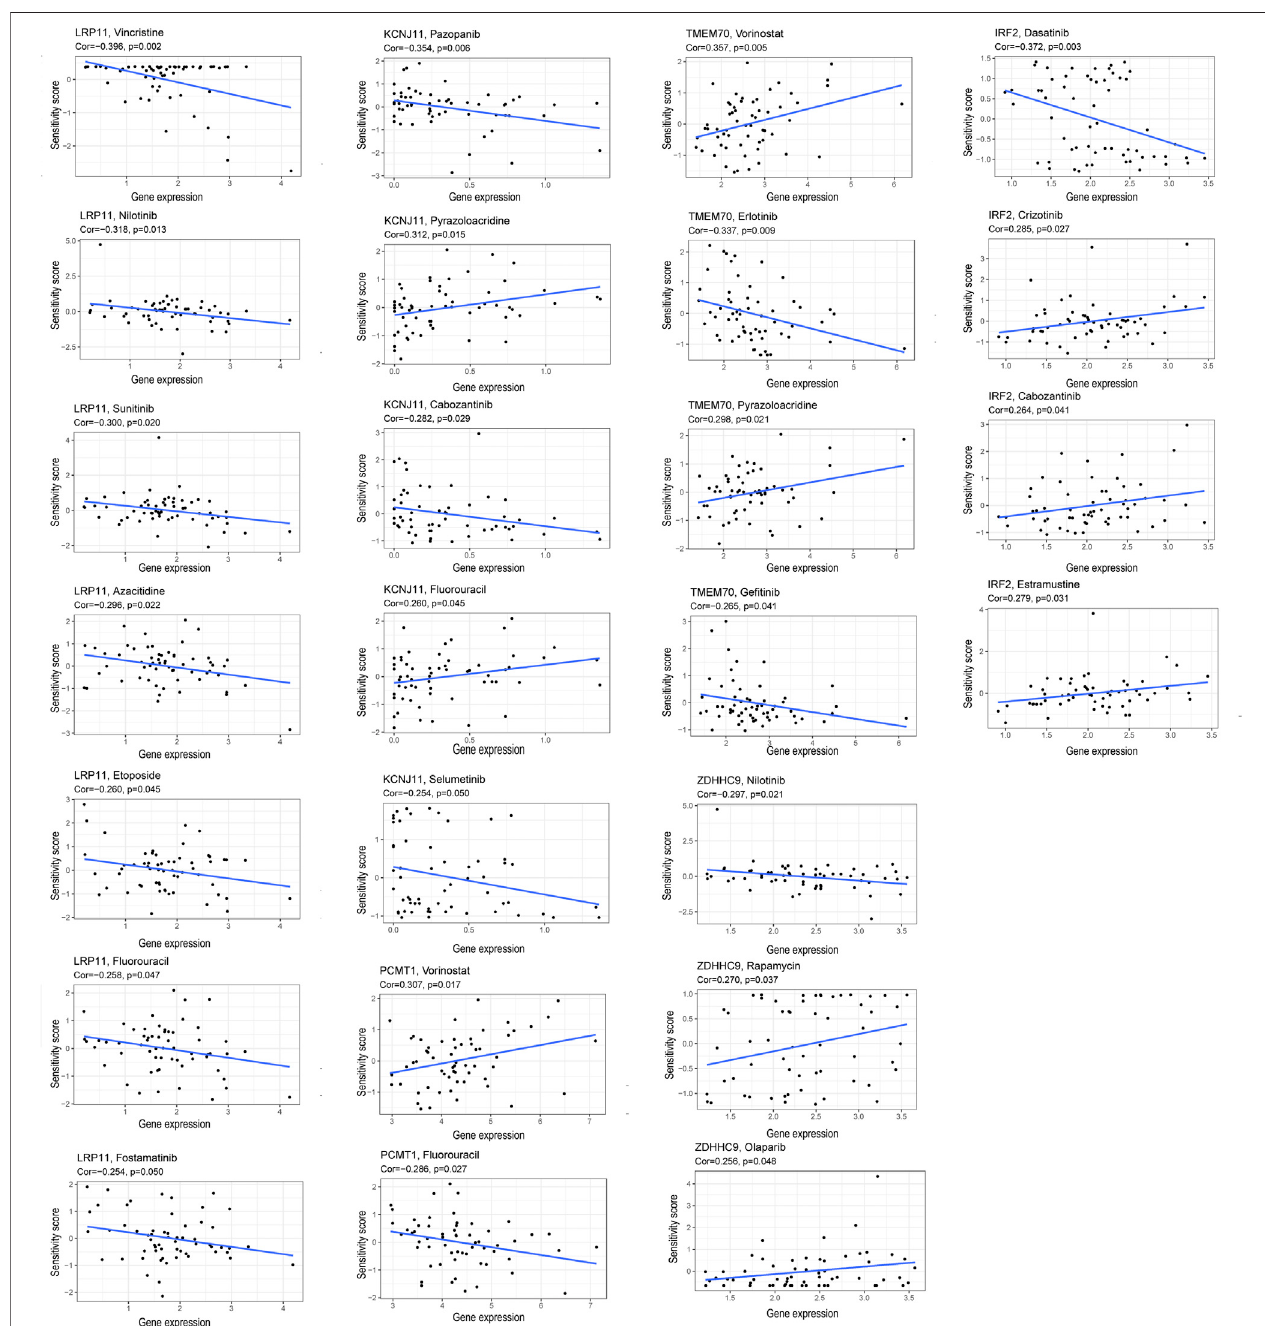
FIGURE 11 | Correlation of the expression of the six prognostic genes and the sensitivity of anti-tumor drugs.